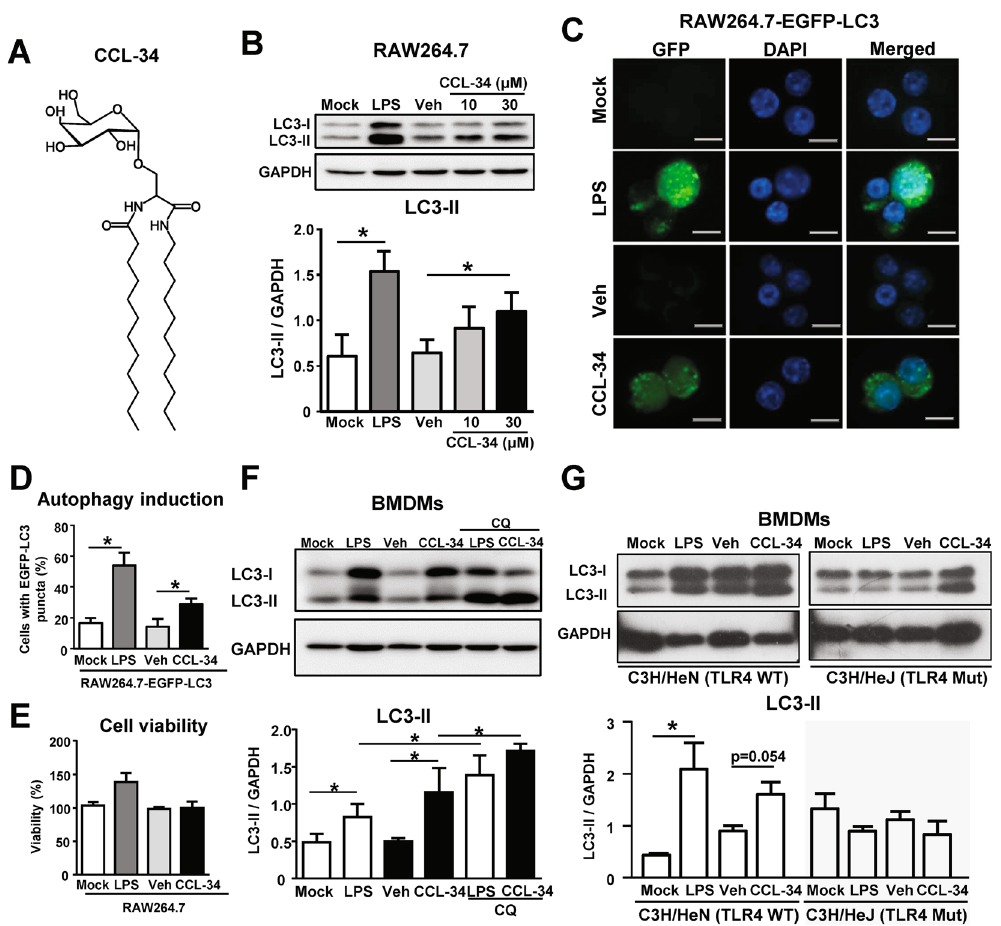
Figure 1. CCL-34 enhanced autophagy in macrophages in a TLR4-dependent manner. (A) The chemical structure of CCL-34 (B) CCL-34 promotes LC3-II production in macrophages. RAW264.7 cells were incubated with LPS (100 ng/mL), vehicle (0.1% DMSO), or CCL-34 (10 μ M and 30 μ M) for 24 hr. The LC3-II protein was detected by immunoblotting, using GAPDH as an internal control (n = 5). (C,D) CCL-34 promotes autophagosome formation in macrophages. RAW264.7-EGFP-LC3 cells were incubated with LPS (100 ng/ mL), vehicle (0.1% DMSO), or CCL-34 (30 μ M) respectively for 24 hr. Cells were fixed and stained with DAPI (blue). The quantification data (n = 5) are shown in (D) . (E) CCL-34 at 30 μ M dose not cause cytotoxicity on RAW264.7 cells. RAW264.7 cells were treated with LPS (100 ng/mL), vehicle (0.1% DMSO), or CCL-34 (30 μ M) for 24 hours, and the cell viability was measured by MTT assay (n = 3). (F) CCL-34 induces autophagy via enhancing autophagosome formation. Primary bone marrow-derived macrophages (BMDMs) were generated from C57BL/6 mice. BMDMs (1 × 10 6 ) were incubated with LPS (100 ng/mL), vehicle (0.1% DMSO), or CCL-34 (30 μ M) in the presence or absence of CQ (30 μ M) for 24 hr. The LC3-II protein was detected by immunoblotting (n = 4). (G) CCL-34 induces autophagy in a TLR4-dependent manner. C3H/HeN (wild type) BMDMs and C3H/HeJ (TLR4-defective) BMDMs (1 × 10 6 ) were incubated with LPS (100 ng/mL), vehicle (0.1% DMSO), or CCL-34 (30 μ M) for 24 hr. The LC3-II protein was detected by immunoblotting (n = 3). All the data are shown as the mean ± SD, and * p < 0.05 indicates a significant difference versus the medium control or vehicle control analyzed using Student’s t-test, and the results were plotted using GraphPad Prism version 8.1.0 (www.graphpad.com). Total protein (50 μ g for RAW 264.7 cells or 25 μ g for BMDM) were analyzed using immunoblotting. The uncropped full-length blots of ( B ), ( F ) and ( G ) are shown in Supplementary Figure